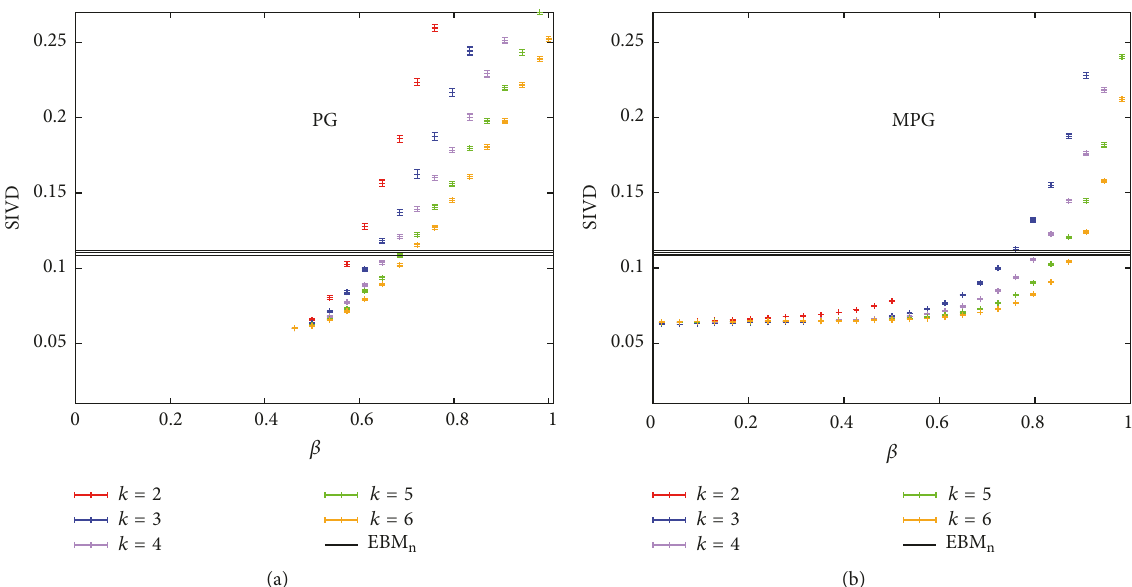
Figure 3: Dependence of model SIVD on the 𝛽 parameter, for several values of the number of prototypes 𝑘 (legend), for the PG (a) and MPG (b) models, where the 𝛼 parameter is tuned such that the empirical AIVD is reproduced. The error bars of the points show the numerical uncertainty ranges, while the horizontal lines show the empirical SIVD uncertainty range (one standard error on each side of the